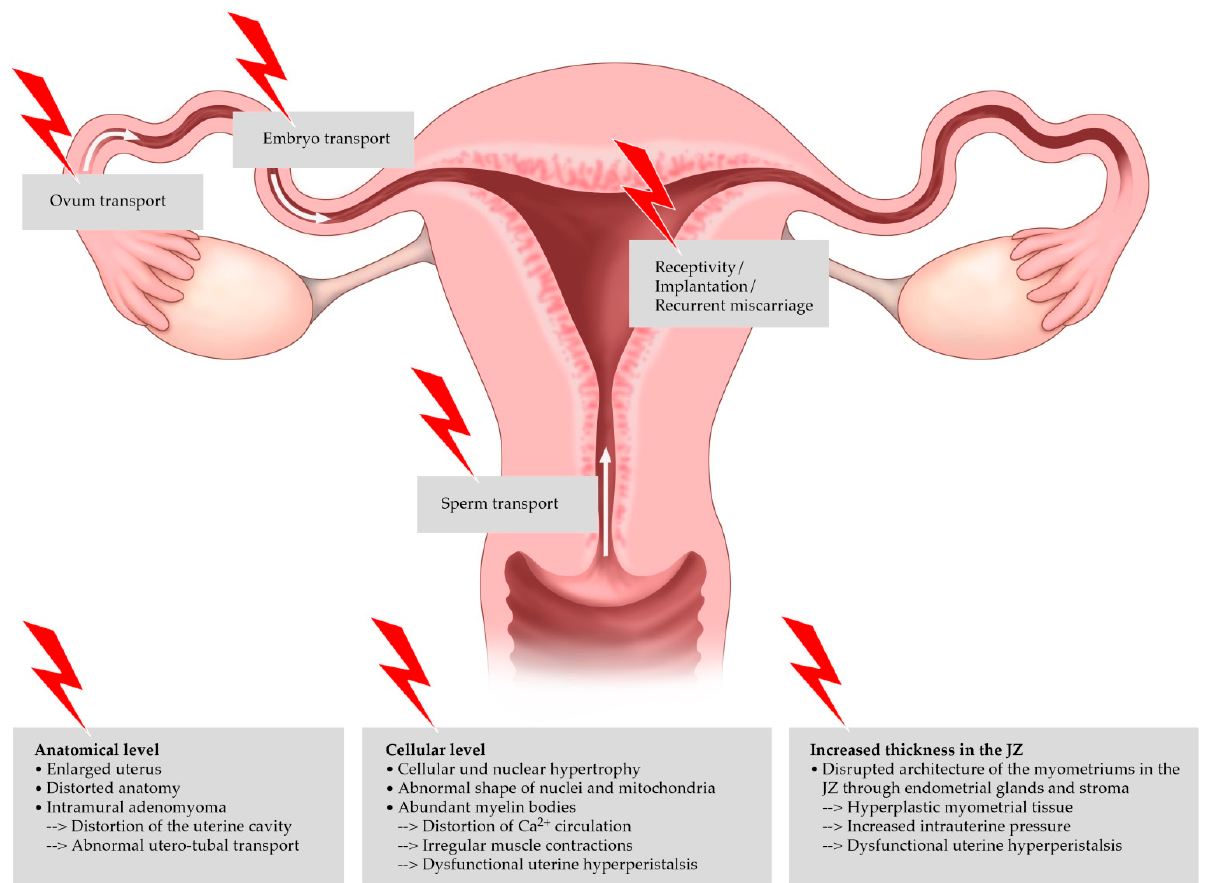
Figure 3. Negative impact of adenomyosis on reproductive outcomes. Adenomyosis leads to changes in the junctional zone (JZ), the anatomy of the uterus itself, and at the cellular level. The transport of the sperm, egg, and finally the embryo is complicated by dysfunctional peristalsis. Adenomyosis is associated with advancing maternal age, which in turn is correlated with lower pregnancy rates due to reduced oocyte quality and lower ovarian reserve [41].